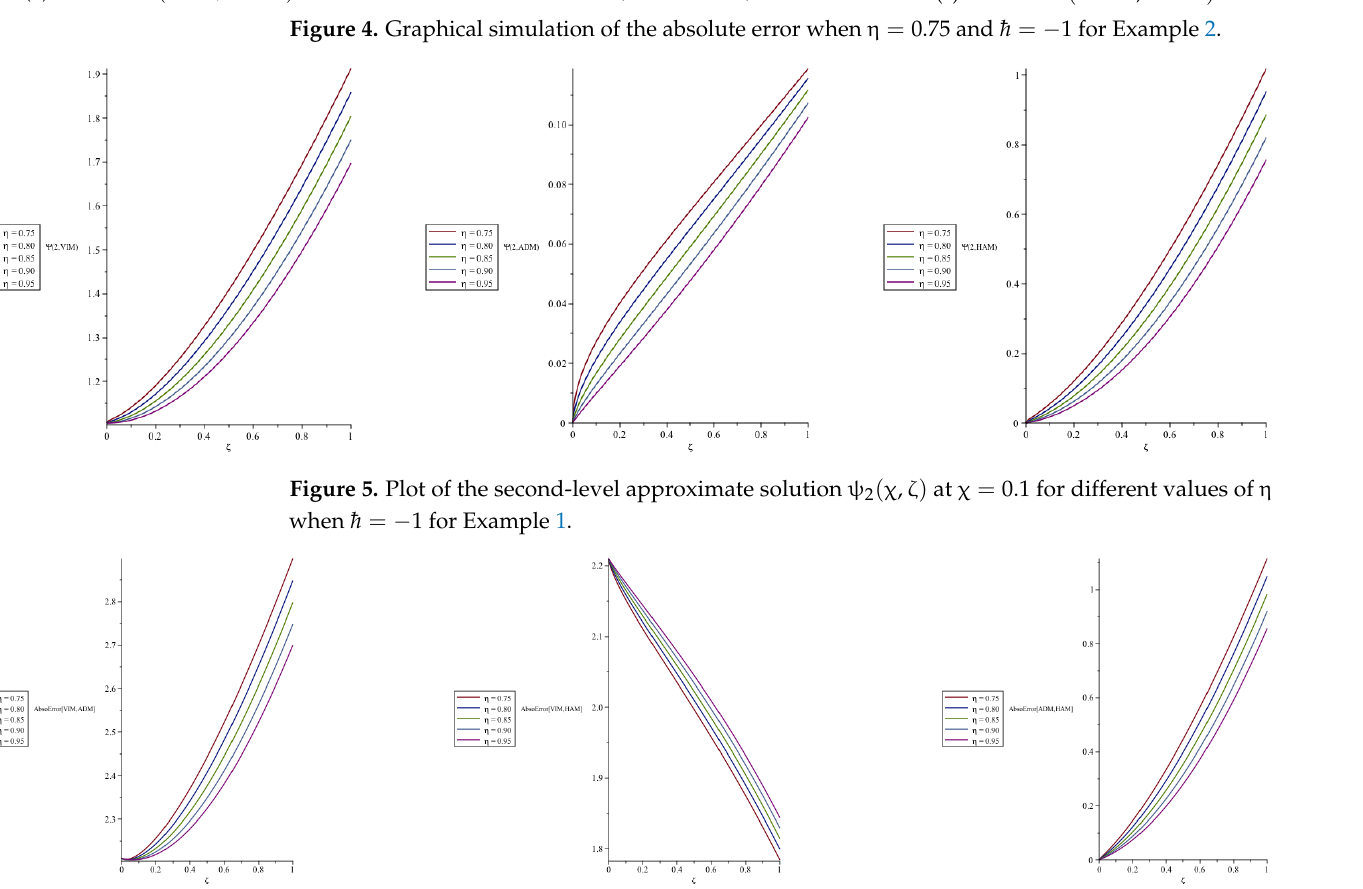
Figure 6. Plot of the absolute errors at χ = 0.1 for different values of η when ¯ h = − 1 for Example